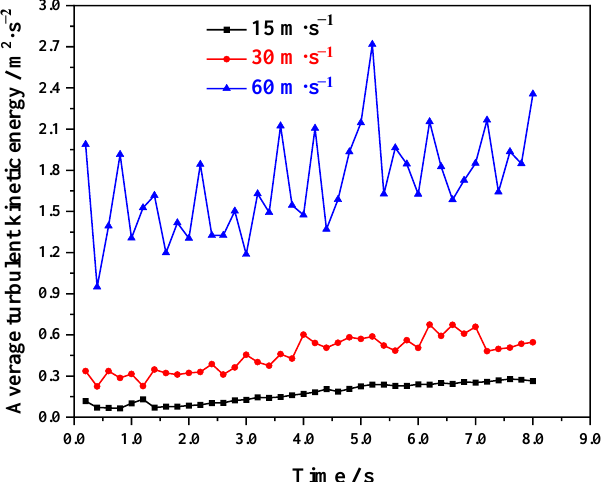
Figure 10. The average turbulent kinetic energy varies with time under different inlet velocities (density: 1650 kg/m 3 , viscosity: 0.0055 Pa·s).